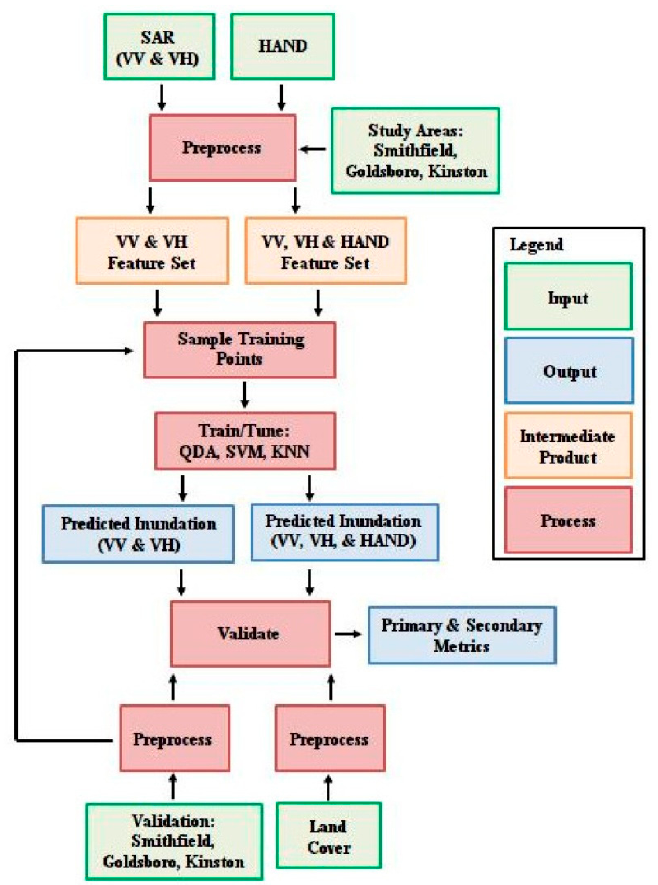
Figure 2. Methodology overview for study.